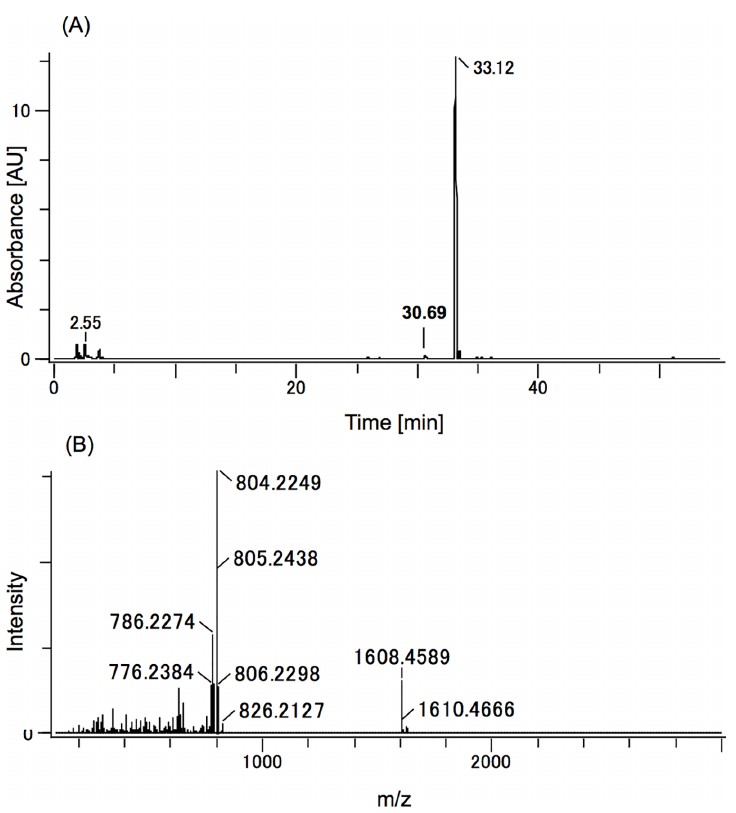
Fig 1. Purity of synthesized mahafacyclin B. (A) UV–Visible spectrum of LC-MS analysisof the sample (0%–100%0.1%TFA CH 3 CN in 45 min). Peak purity was calculatedusing the peak area percentage. RT = 33.12 min was characterized as mahafacyclin B (96.8%) and RT = 30.69 min was found to be the epimerized variant (0.82%), the existence of which was determined by mass chromatogram ( m/z 803–810, data not shown). (B) Mass spectrometry of the main peak in the UV–Visible spectrum of the LC-MS analysis of mahafacyclin B. m/z 804.2249 was characterized as [M+H], and m/z 1608.4589 ( m/z 1607.4438 for the monoisotopic ion) as